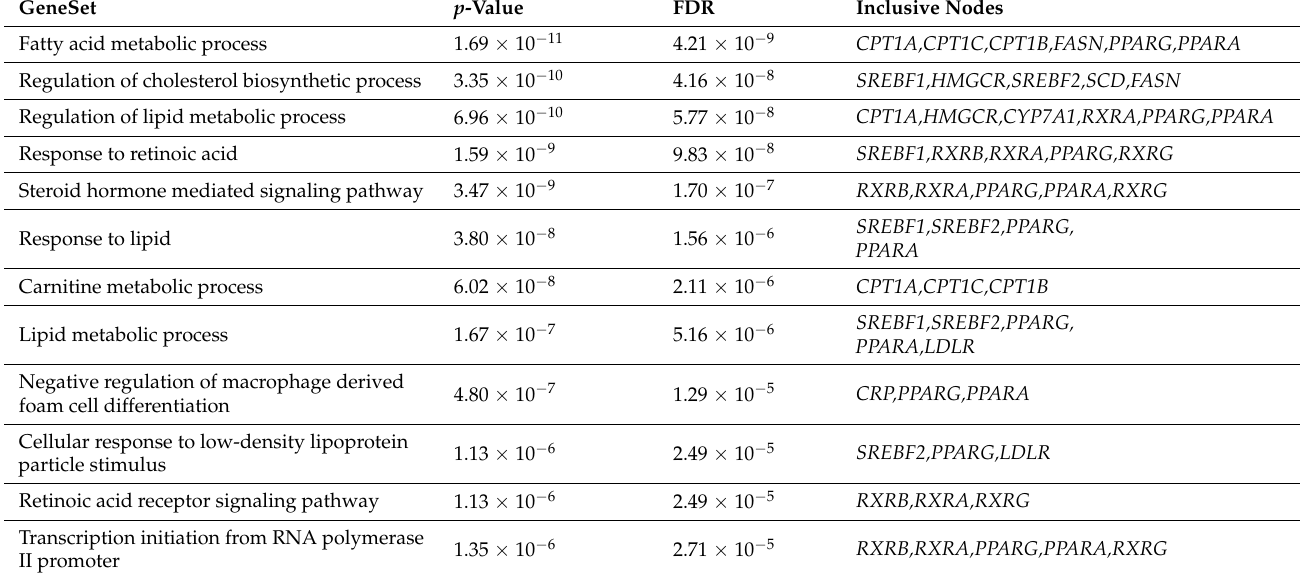
Table 3. Pathway/GO term enrichment analysis of the different genes using Reactome as discussed in this manuscript.